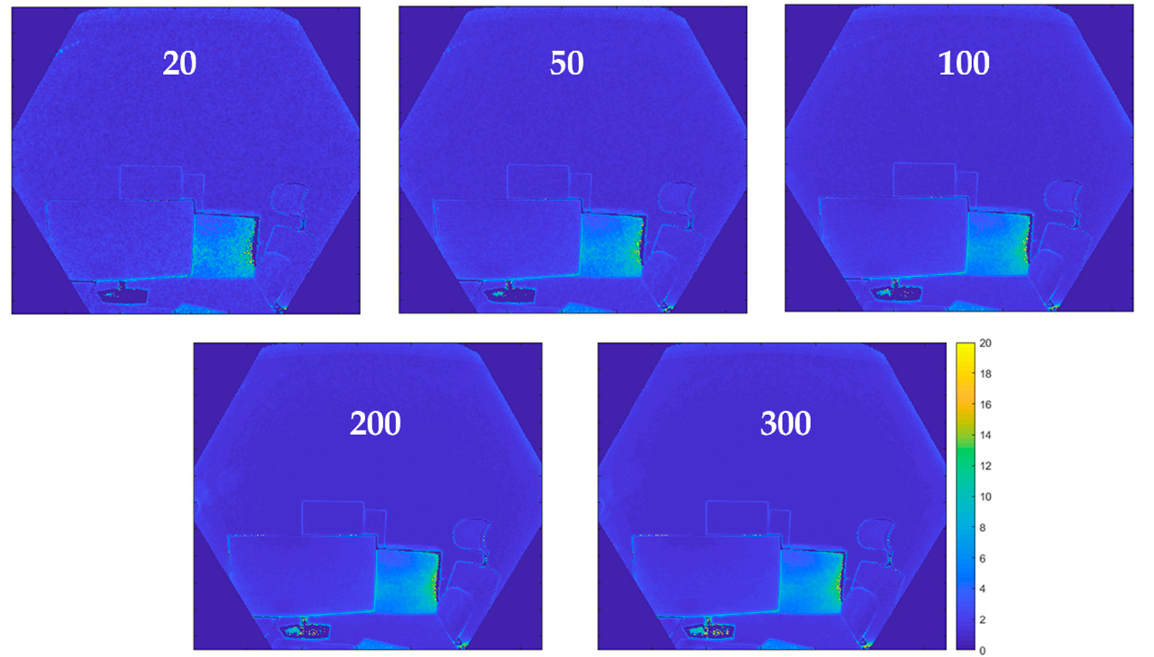
Figure 8. Evolution of standard deviations [in mm] of measurements according to the number of averaged frames.